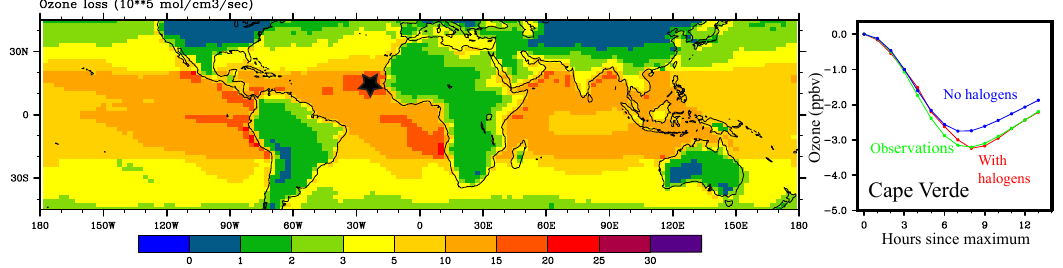
Fig. 5. (Left) Surface ozone loss (in 10 5 moleculecm − 3 s − 1 ) resulting from including tropospheric halogen chemistry in CAM-Chem. (Right) Annual average of diurnal ozone loss observed and simulated by CAM-Chem (without and with tropospheric halogen chemistry) at Cape Verde.